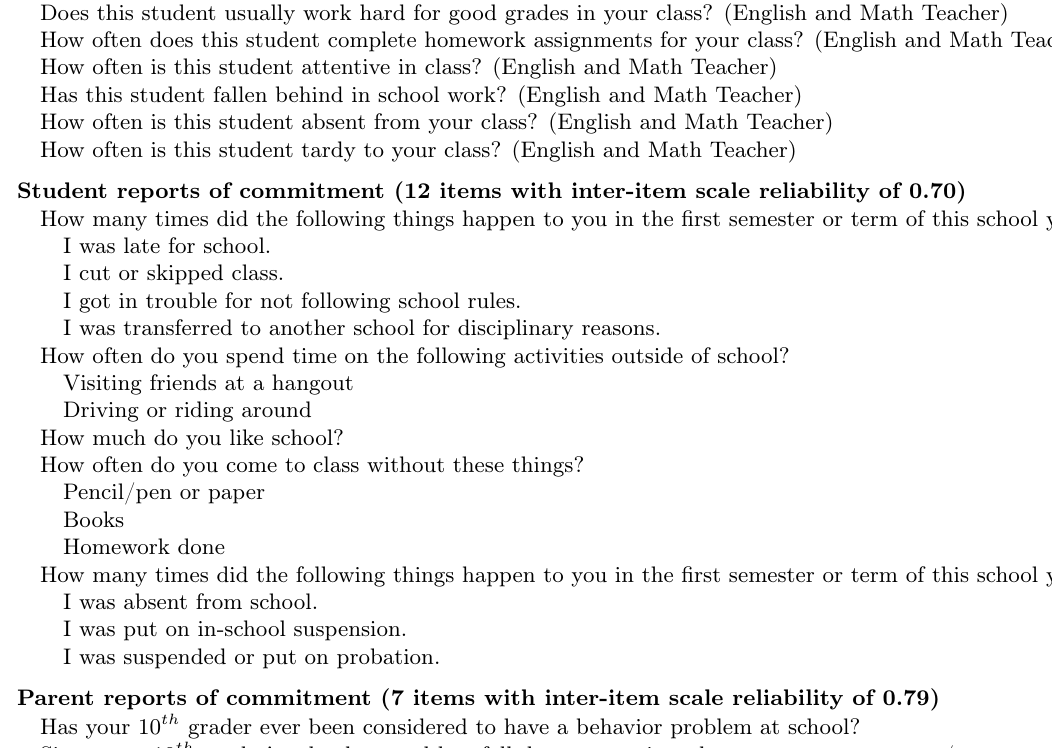
Table 3: Indicators of Commitment in the 10 th Grade Teacher reports of commitment (12 items with inter-item scale reliability of 0.77) Does this student usually work hard for good grades in your class? (English and Math Teacher) How often does this student complete homework assignments for your class? (English and Math Teacher) How often is this student attentive in class? (English and Math Teacher) Has this student fallen behind in school work? (English and Math Teacher) How often is this student absent from your class? (English and Math Teacher) How often is this student tardy to your class? (English and Math Teacher) Student reports of commitment (12 items with inter-item scale reliability of